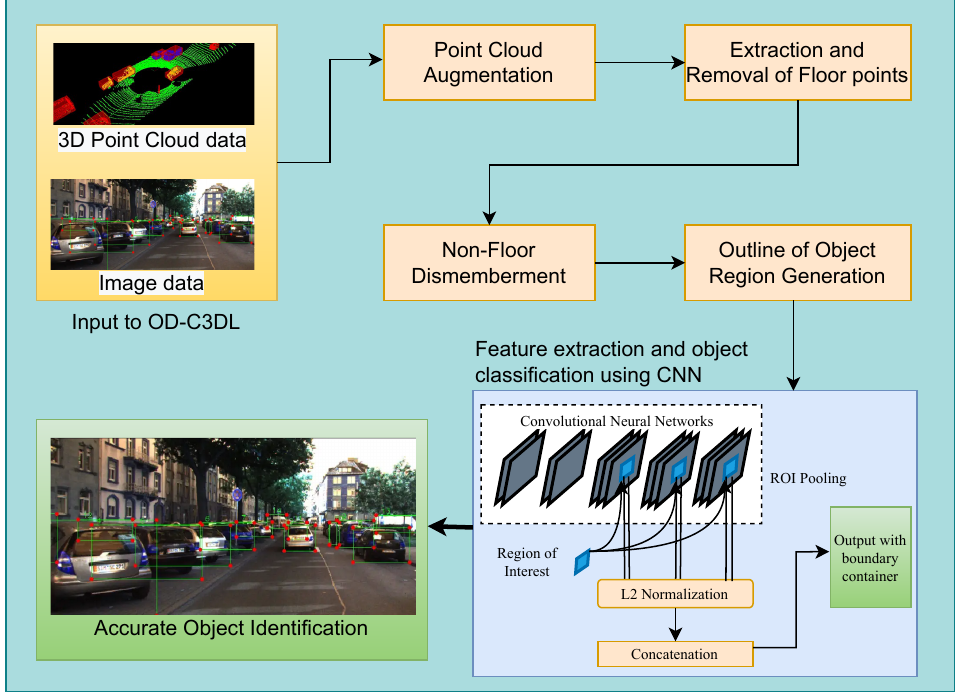
Figure 1. Overview of the proposed object detection methodology from the camera sensor and 3D LiDAR sensor